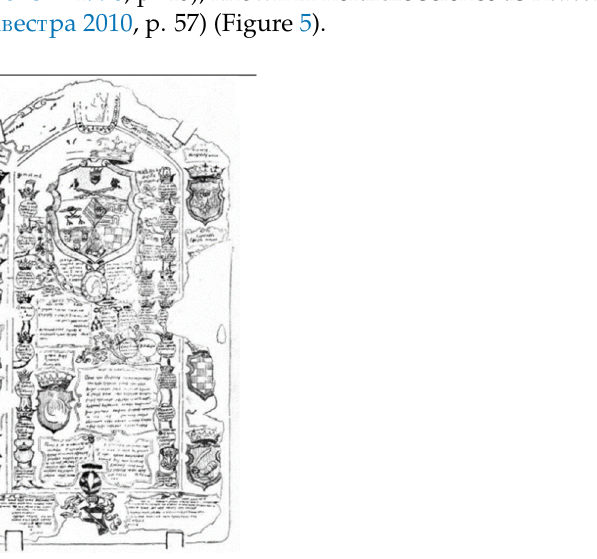
Figure 5. A drawing of the Rodoslovlje gospode Srpske i Bosanske.